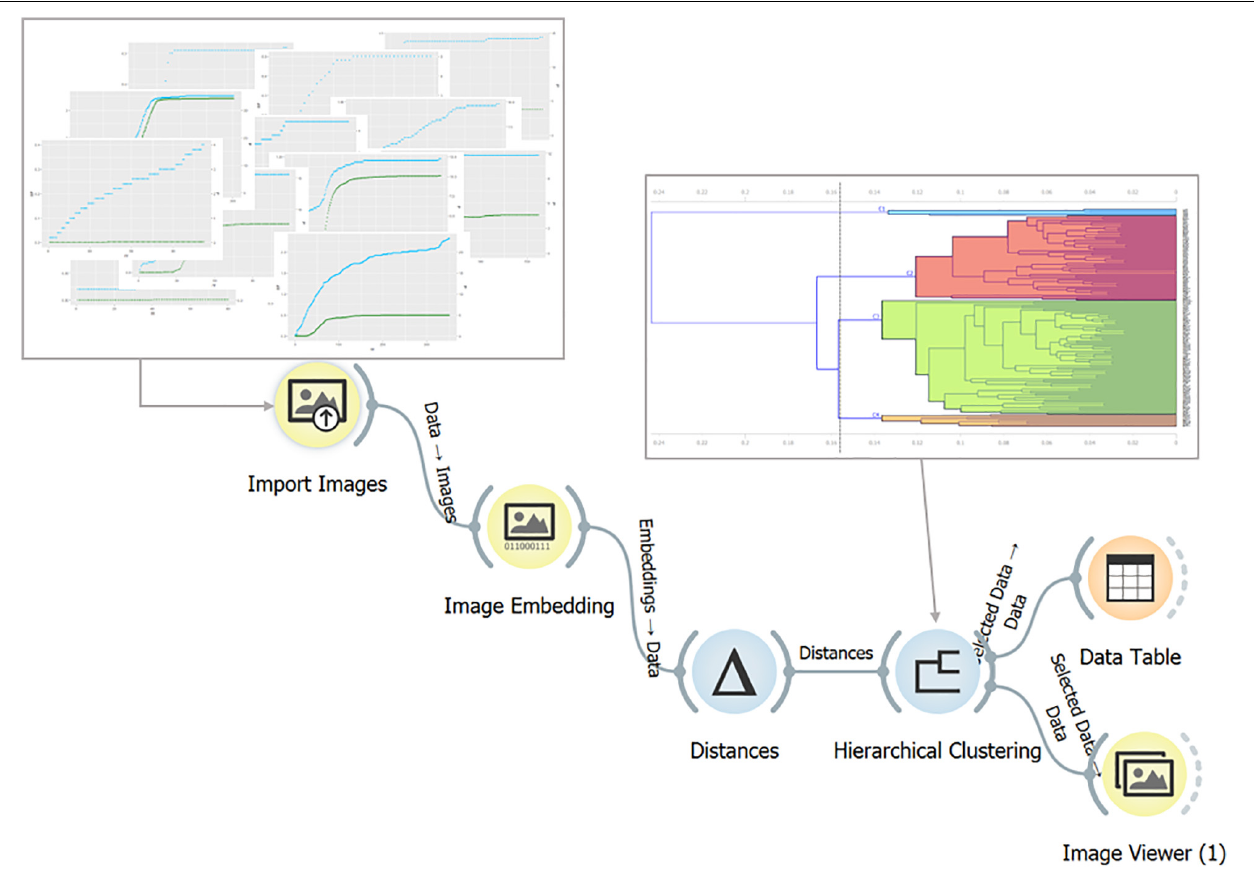
FIGURE 2 | A flowchart of the steps for hierarchical clustering in Orange software with examples of imported images and final dendrogram with division into four clusters. TABLE 1 | The total rainfall and stemflow (SF) amounts and average event-based values of rainfall duration (Rd), intensity (Ri), wind speed (Ws), air temperature (T) and vapor pressure deficit (VPD) for the events during the individual phenoseasons.